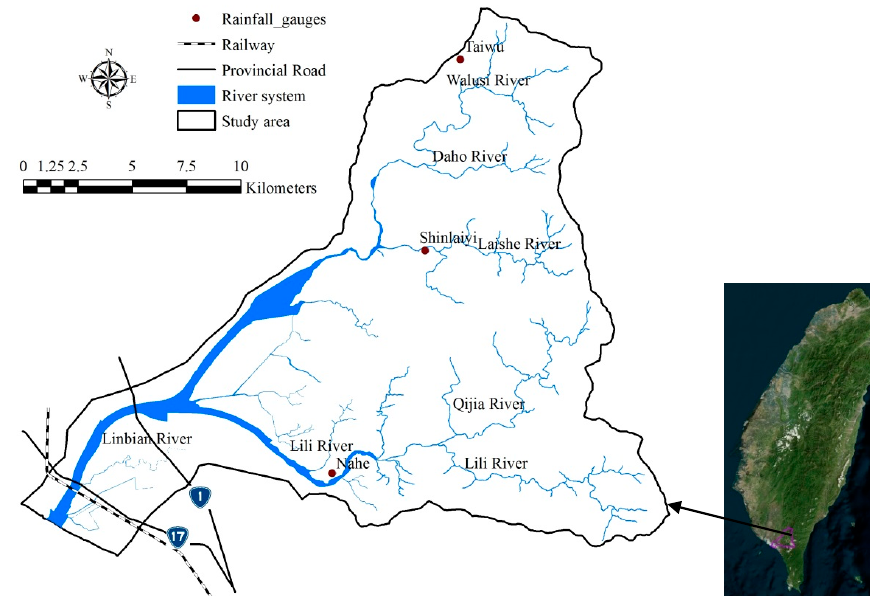
Figure 1. Linbian River Drainage basin.